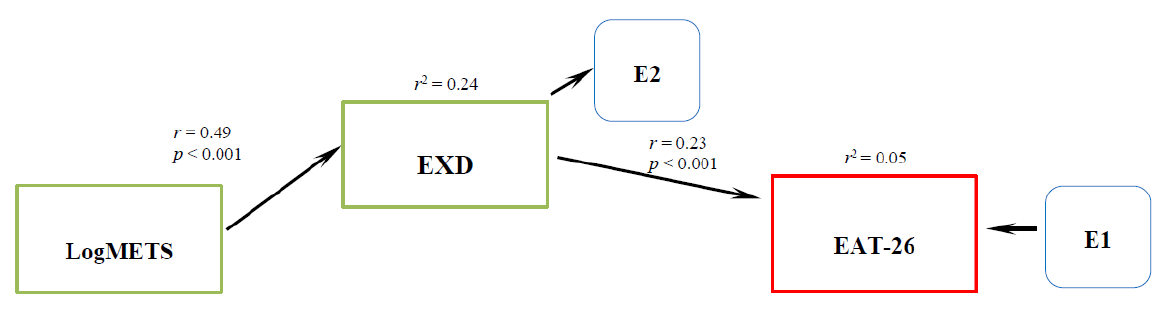
Figure 4. Final Path analysis of the relationship between LogMETS, EXD and EAT-26 for